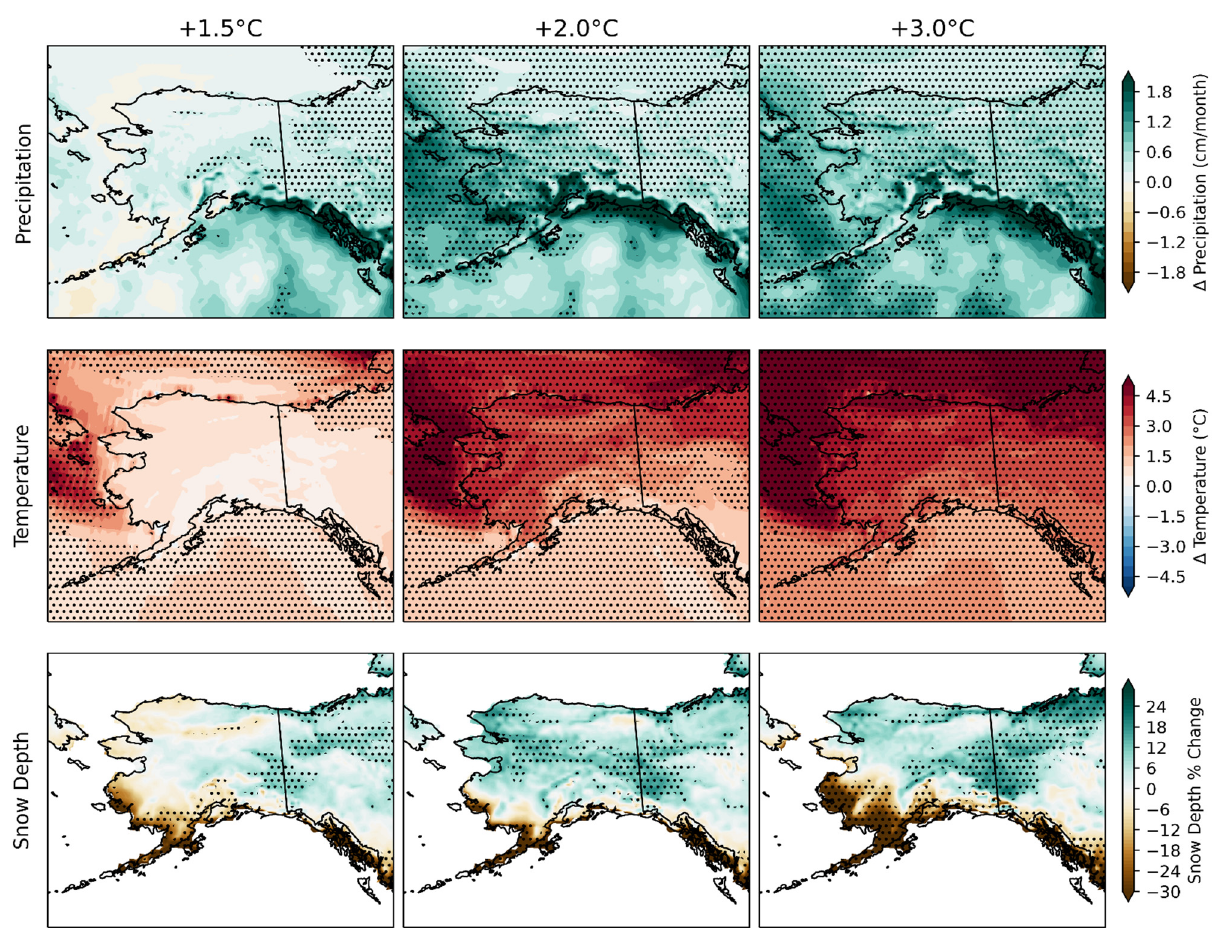
Figure 7. Same as Figure 6, but for Alaska.